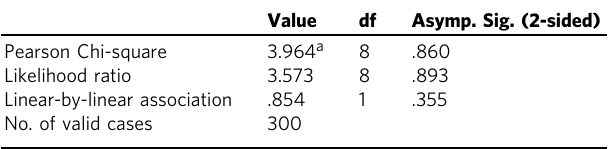
Table 5 Chi-Square